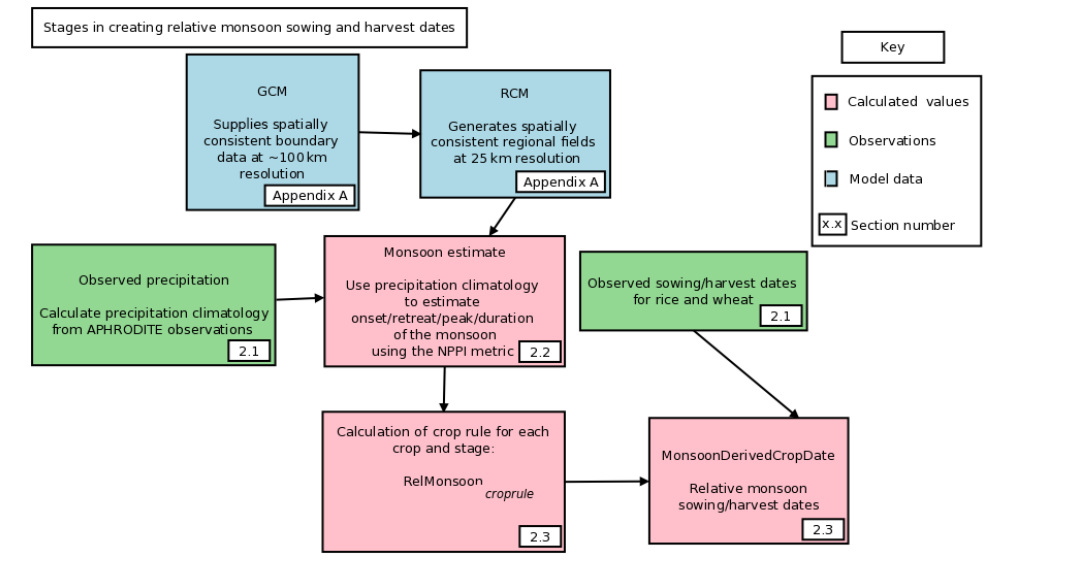
Figure 2. A flow chart summarizing the methodology. The blue rectangles represent datasets that are used within the methodology, green rectangles represent observations, and pink rectangles represent any calculation parts of the